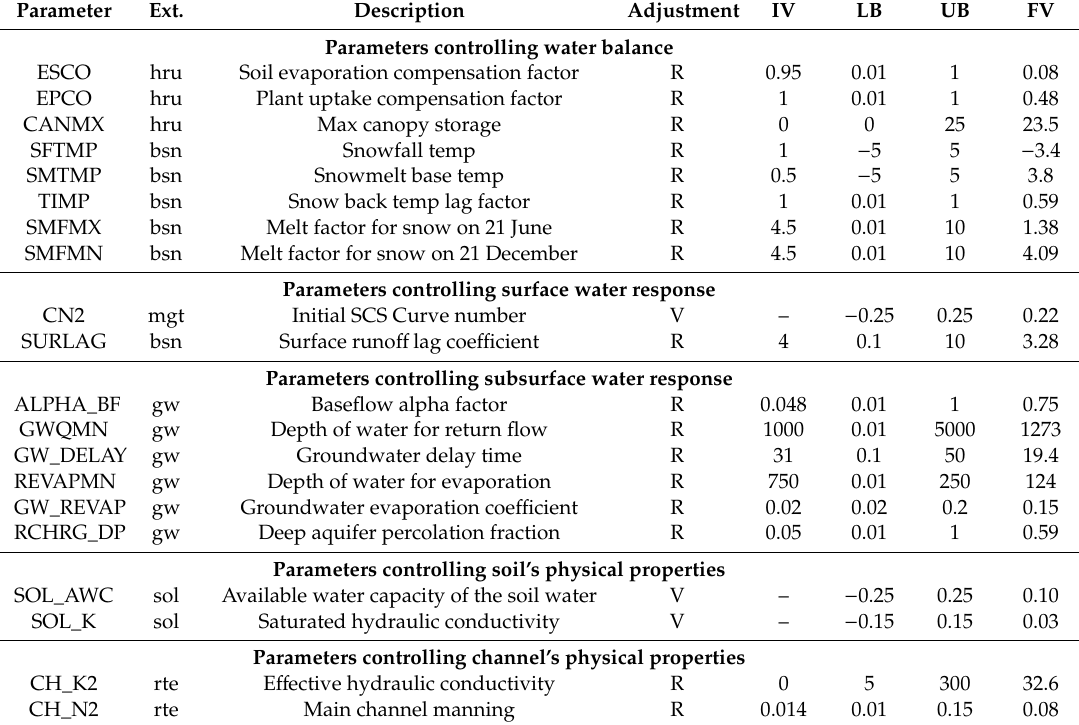
Table 5. SWAT input parameters used for the LEC calibration of streamflow and baseflow. Parameter